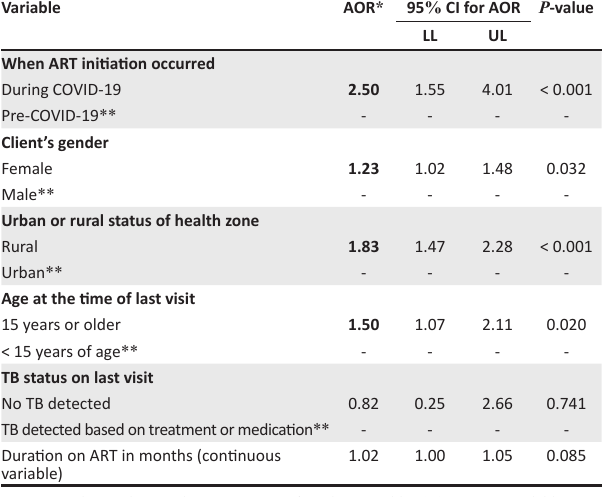
odds ration = 1.0, P = 0.566. ART, antiretroviral treatment; TB, tuberculosis; COVID-19, coronavirus disease 2019. * , P -values are based on Cramer’s V (nominal by ordinal). ** , P -values are based on Somers’ D test (ordinal by TABLE 4: Odds ratios from logistic regression model of whether patients on antiretroviral treatment had their viral load < 1000 copies/mL, pre-COVID-19 and during COVID-19, after controlling for other covariates, March 2019 to March 2021.